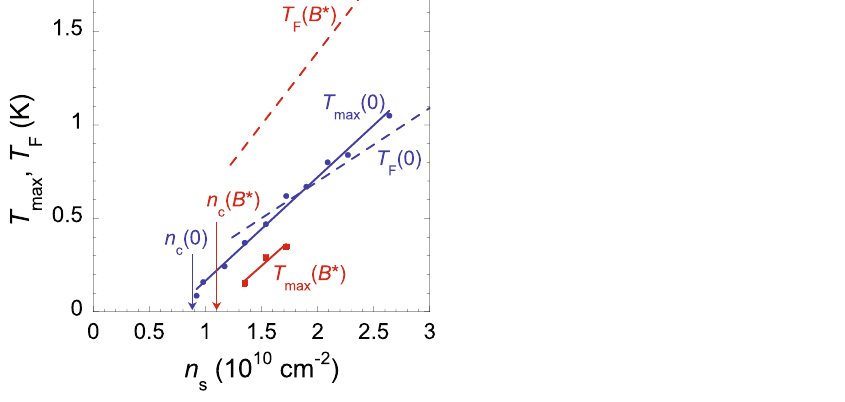
Figure 2. T max as a function of electron density in B = 0 (circles) and in B = B ∗ (squares). Solid lines are linear fits. Critical electron densities for the metal-insulator transition in B = 0 and B = B ∗ are indicated. Dashed lines show the Fermi temperatures T F in B = 0 and B = B ∗ calculated using the low-temperature value B ∗ and Eq. (1), see